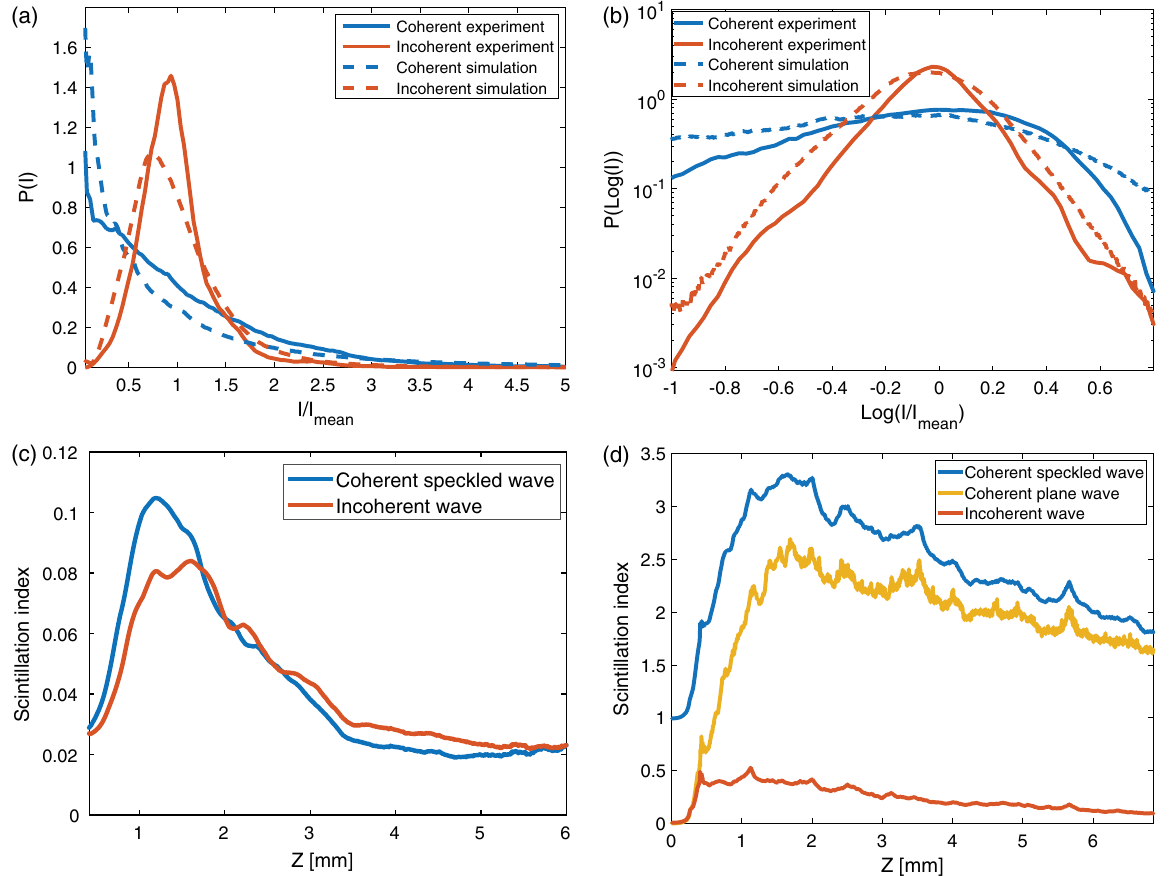
FIG. 5. (a) Probability distribution of coherent and incoherent BF intensity as observed in experiments and in simulations. The intensity distribution of BF is narrower for spatially incoherent light, and the probability to observe very high or low intensities is smaller than for the coherent waves. (b) The same data as in (a) on a P ½ Log ð I Þ(cid:2) − Log ð I=I scale. The coherent distribution is broad, while mean Þ the incoherent one is concentrated around the mean. (c) Scintillation index along the propagation direction calculated from experimental data. The similar peak position discloses that branching starts at the same distance for coherent and spatially incoherent light. The measured values in (c) are reduced (compared to the true values) by additional background light, which is inevitable when coupling a multimode (or incoherent) beam into a thin film. (d) Scintillation index calculated from simulations for coherent, speckled, and incoherent waves. Branching starts at the same distance for all cases, but the intensity fluctuations are markedly